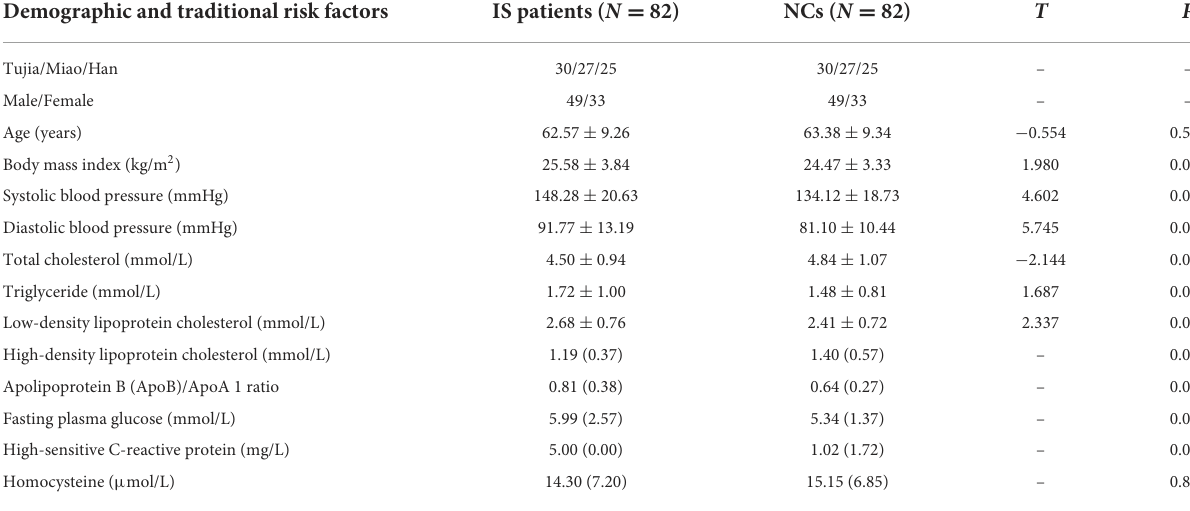
TABLE 1 Demographic and traditional risk factors of recruited subjects. Demographic and traditional risk